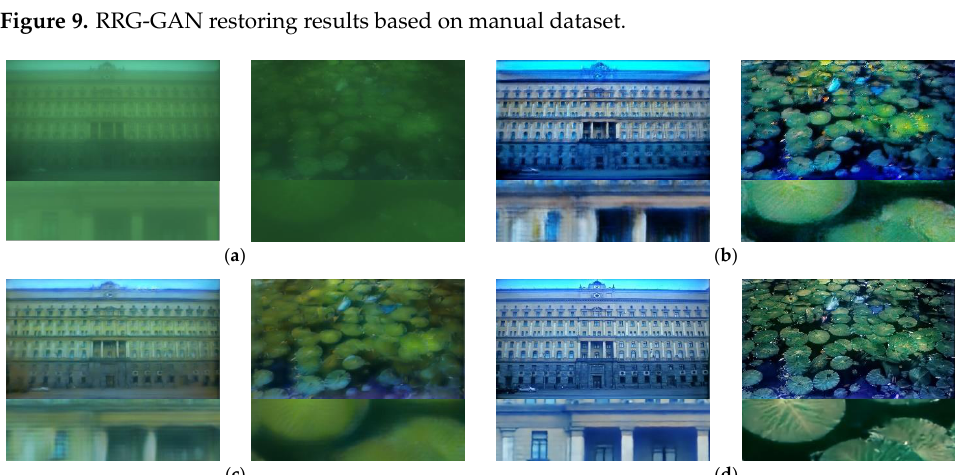
Figure 9. RRG-GAN restoring results based on manual dataset.